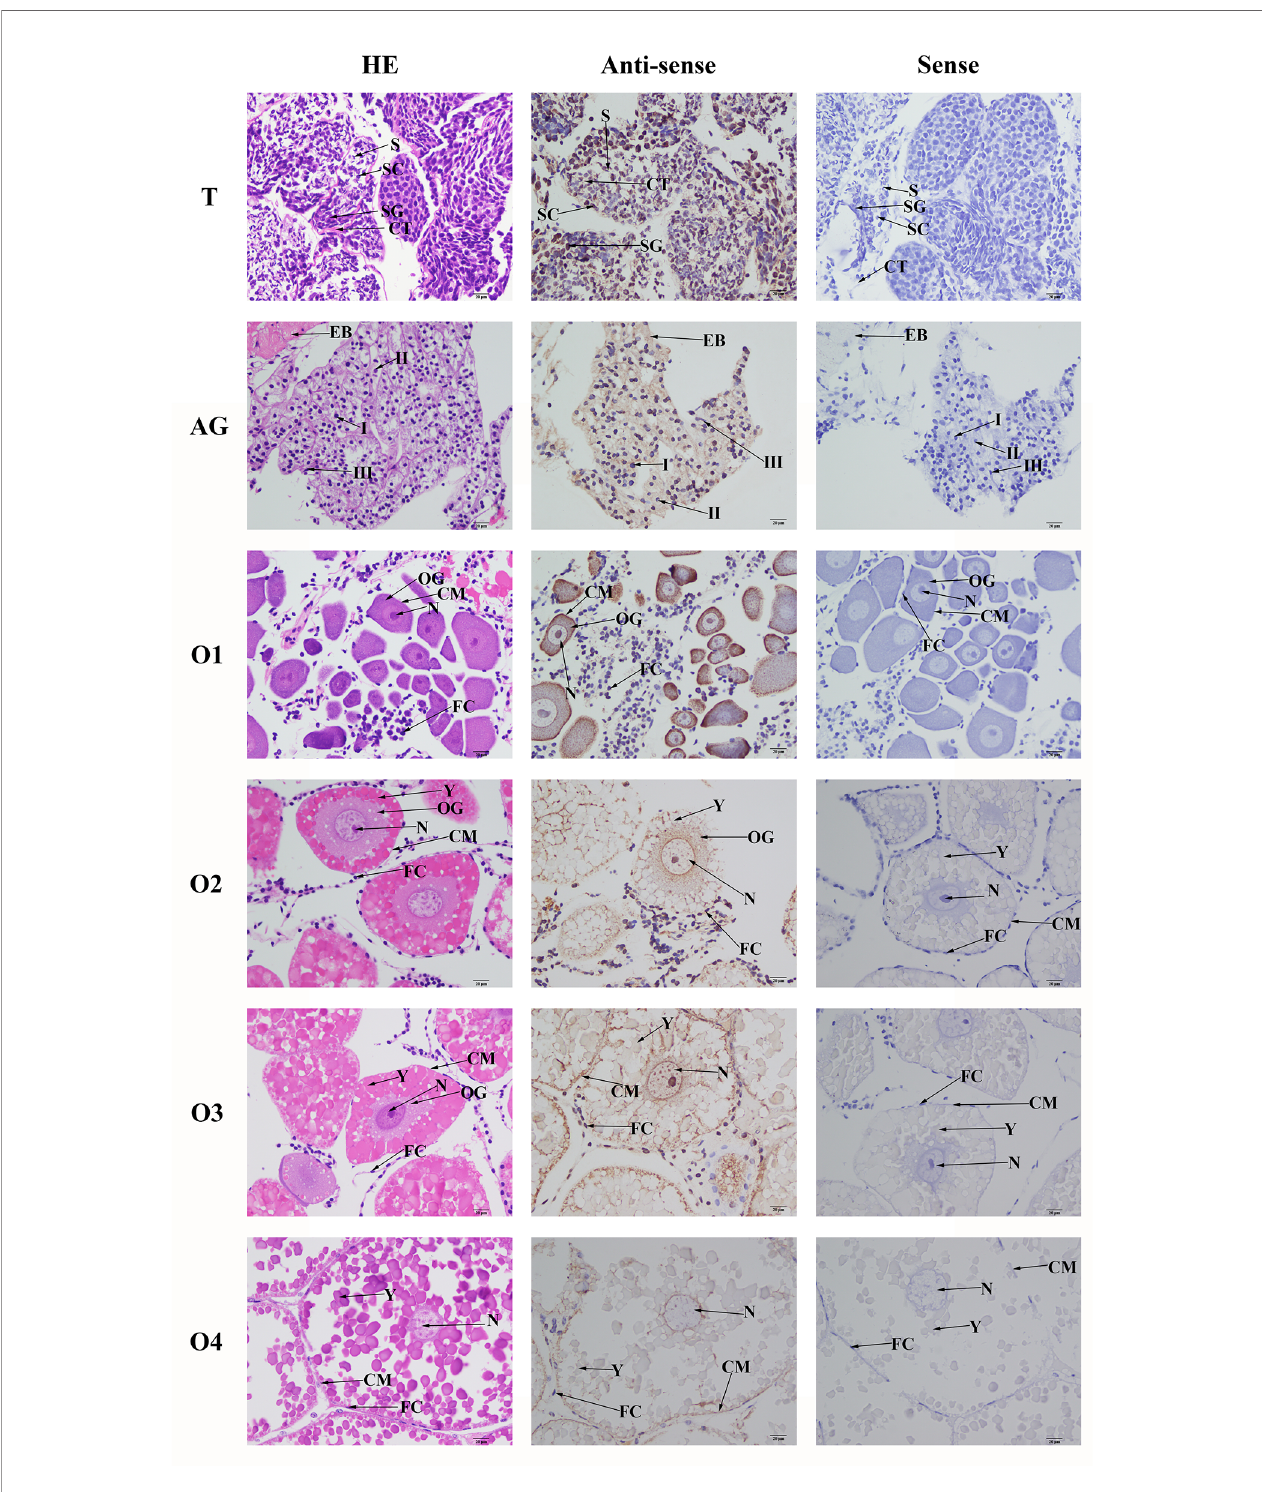
FIGURE 7 | Location of PDHE1 gene was detected in testis, androgenic gland and ovary of M . nipponense by using in situ hybridization. ST, seminiferous tubule; SG, Spermatogonia; SC, spermatocyte; S, sperm; CT, collecting tissue; E, wall epithelium; EM, eosinophilic matrix; VD, vas deferens; EB, ejaculatory bulb; OG, oogonium; OC, oocyte; CM, cytoplasmic membrane; N, nucleus; Y, yolk granule; FC, follicle membrane. Scale bars = 20 m